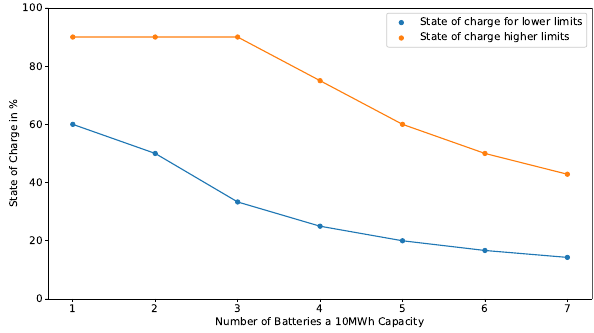
Figure 13. Low and high state-of-charge